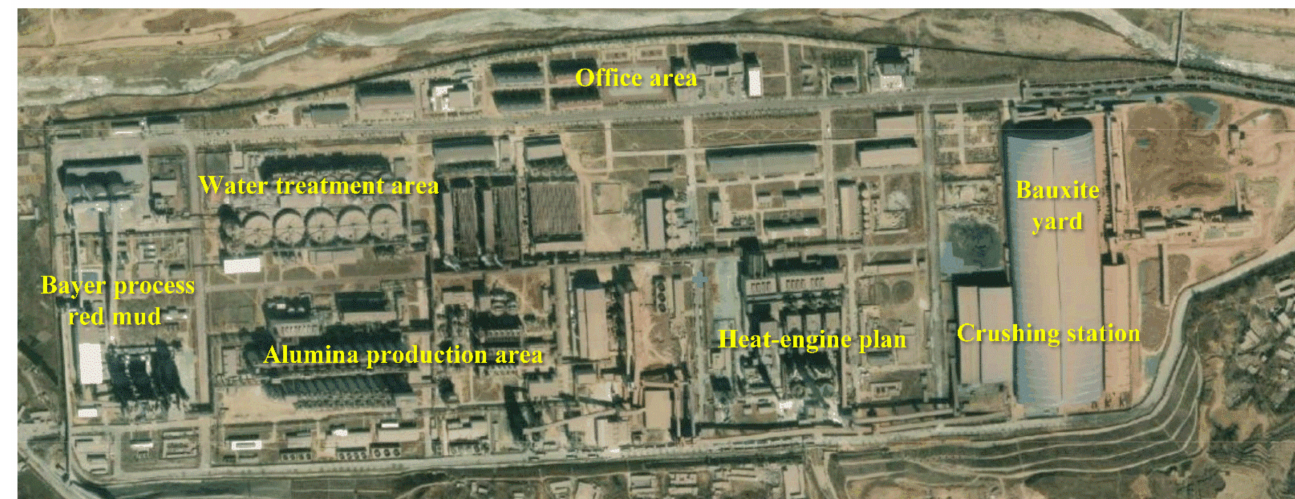
Figure 1. Satellite image of an alumina plant in Shanxi province.